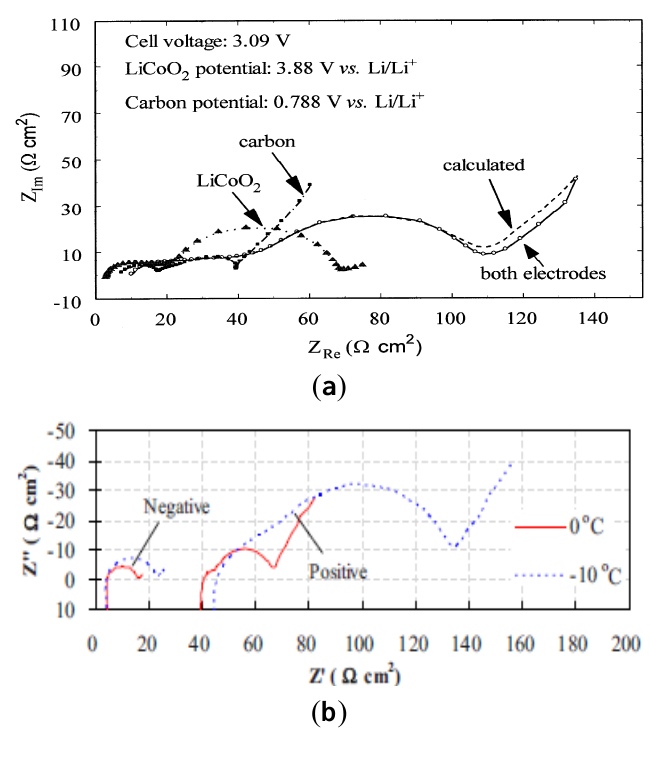
Figure 3. ( a ) Anode contributing less to total battery impedance (charge rate of C/2 at room temperature) [39]; ( b ) Anode contributing less to total battery impedance (graphite Co Al O electrodes: 0.5C charge rate at 40 °C) and LiNi 0.8 0.15 0.05 2